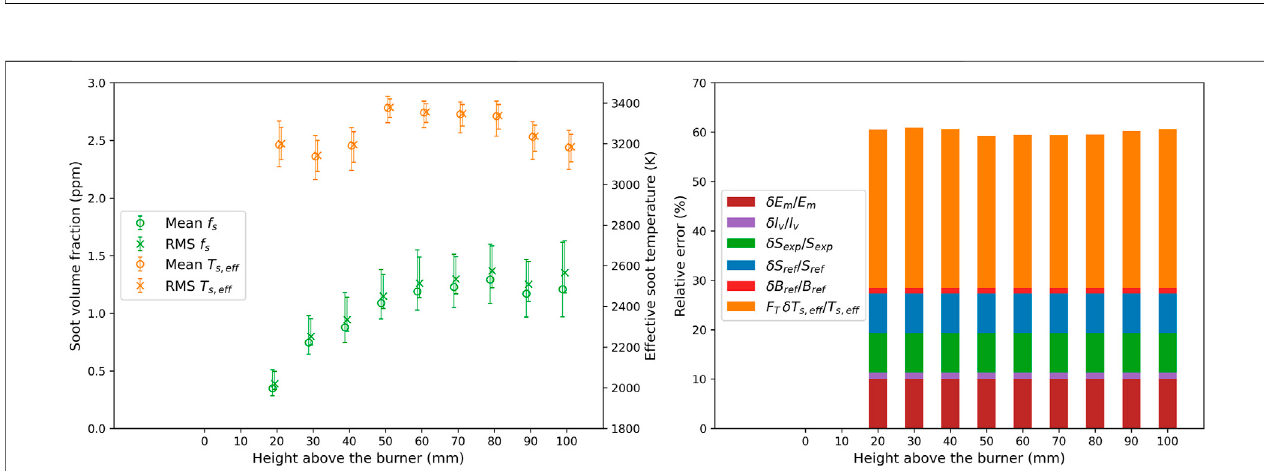
FIGURE8|Onleft: MeanandRMSsootvolumefractionandeffectivesoottemperatureatdifferentHABs.Propertiesaretheaveragedvaluesoftheinstantaneous measurementswithdetectedLIIsignals,whichinturnwerethemeanvaluesbetween35and60 nsafterthelaserpulse. Onright: Relativeerrorsofsootvolumefraction ( δ f s / f s ) disaggregated in terms of the contributions of each variable.